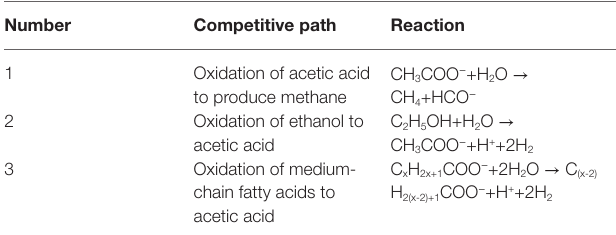
TABLE 2 | Key reactions of competitive path in the production of caproic acid. Number Competitive